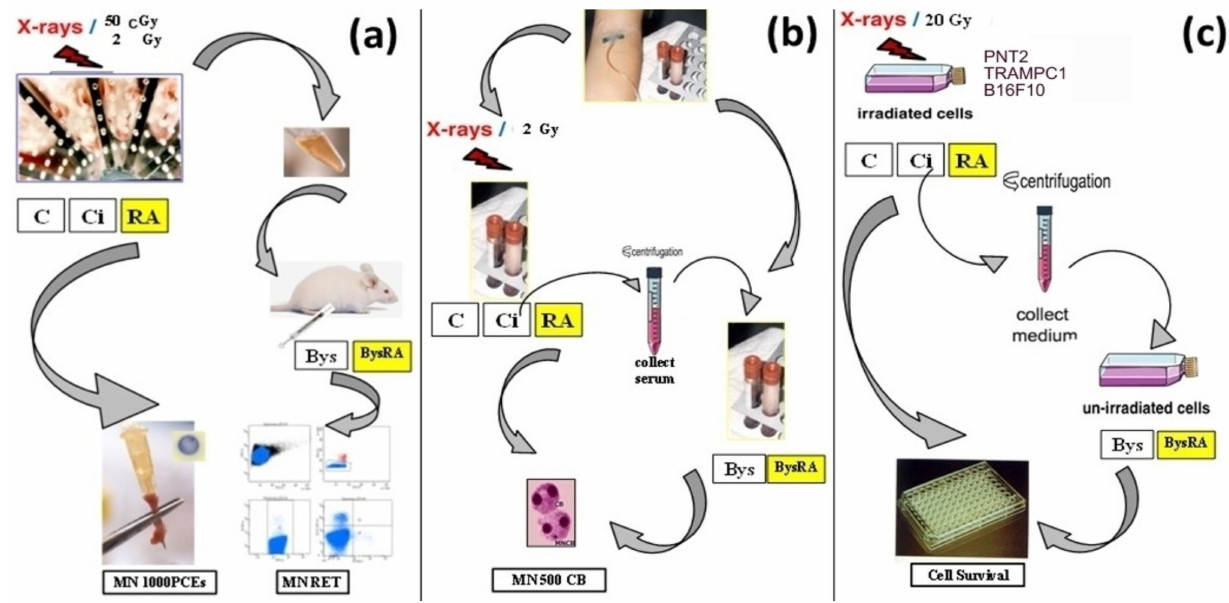
Figure 2. Models of radiation-induced bystander (Bys) effects (RIBE): ( a ) In vivo micronucleus assay (in mouse bone marrow (Micronuclei in polychromatic erythrocytes (MNPCEs)) and reticulocytes (Micronuclei in reticulocytes (MNRET))), ( b ) micronucleus test in vitro (Cytokinesis-block micronucleus assay (CBMN)), ( c ) MTT cytotoxicity